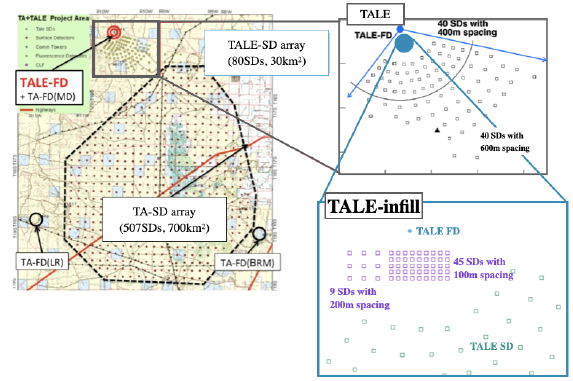
Figure 2: The layout of the TA detector, the TALE detec- tor, and the TALE infill detector. TALE infill SDs, rep- resented by purple square, are located between TALE-FD and